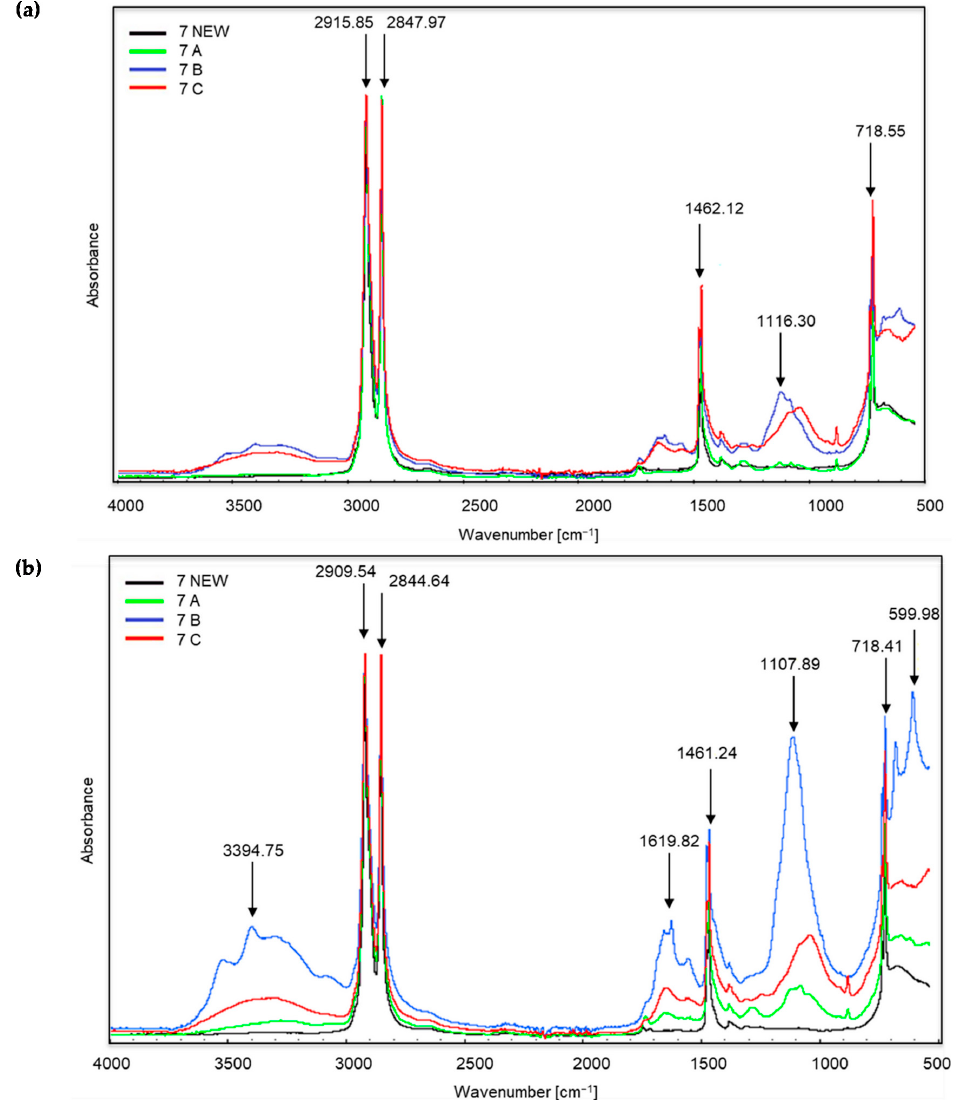
Figure 4. Sample no. 7 spectra: ( a ) spectra generated by the white part of the sample material, ( b ) spectra generated by the coloured part of the sample material.